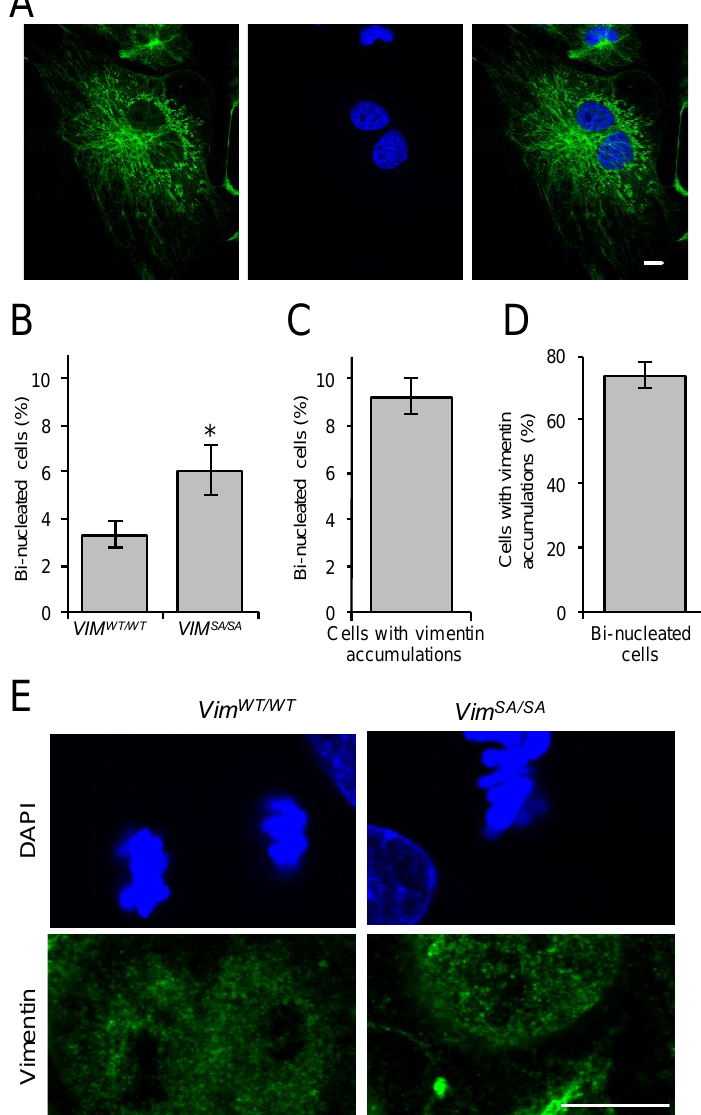
Figure 3. Increased fraction of bi-nucleated cells among immature VIM SA/SA astrocytes. Immature VIM WT/WT and VIM SA/SA astrocytes were labeled with polyclonal antibodies against vimentin (green) and nuclei were visualized with DAPI (blue). Images were taken and bi-nucleated cells were counted.